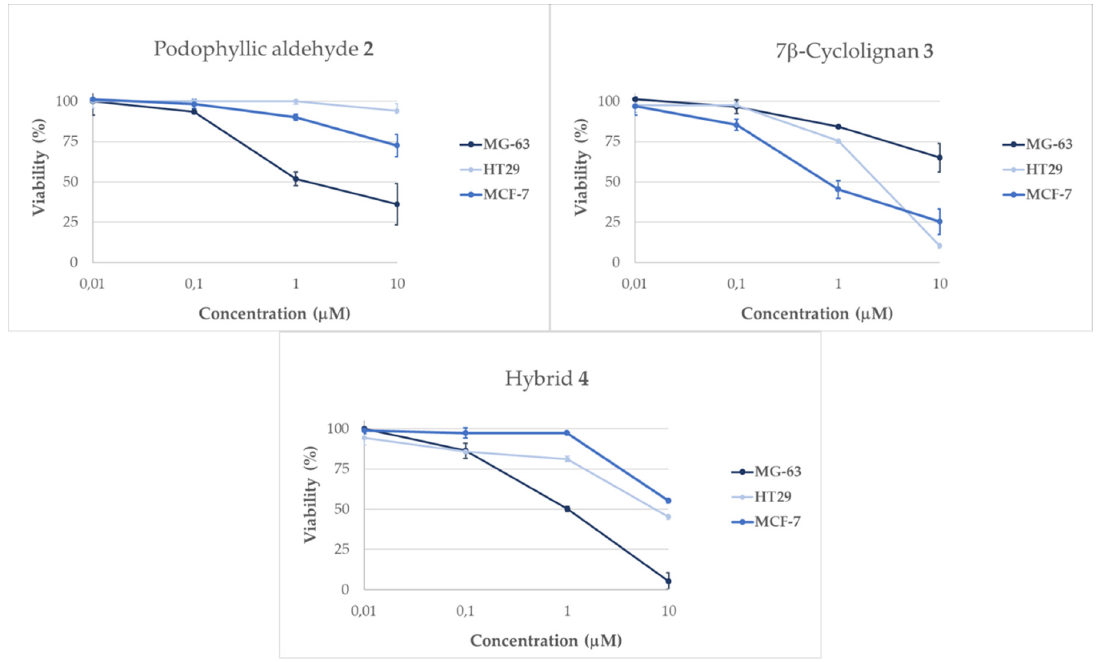
Figure 3. Results obtained from viability assays performed in tumor cells lines MG-63 (osteosarcoma), HT-29 (colorectal cancer) and MCF-7 (breast cancer) for the compounds 2 , 3 and 4 in different concentrations after 24 h of incubation.